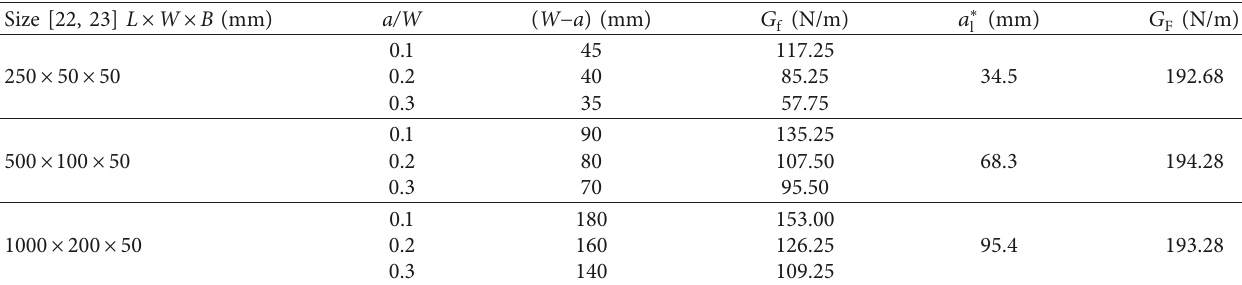
Figure 7: Comparisons of theoretical with measured fracture energy for single-edge notched concrete beams having different depths ( W ) and span-to-depth ( S/W ) ratios. (a) Large size with S / W � 4 and W � 200mm. (b) Large size with S / W � 4 and W � 300mm. (c) Large size with S / W � 2 . 5 and W � 250mm. (d) Large size with S / W � 2 . 5 and W � 400mm. Table 5: Specimens of different sizes and the corresponding calculated fracture energy [22,